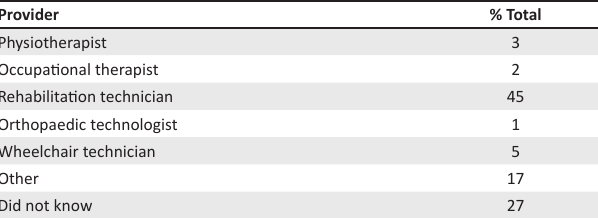
TABLE 2: Profession of person supplying the wheelchair as reported by users ( n = 94).